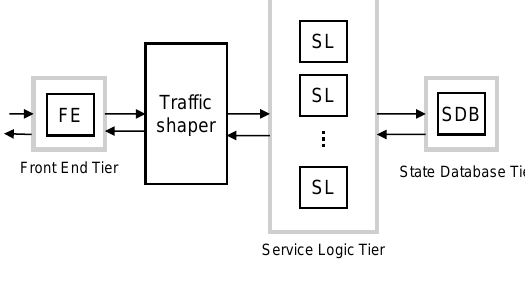
Figure 8. Traffic separated scheme block